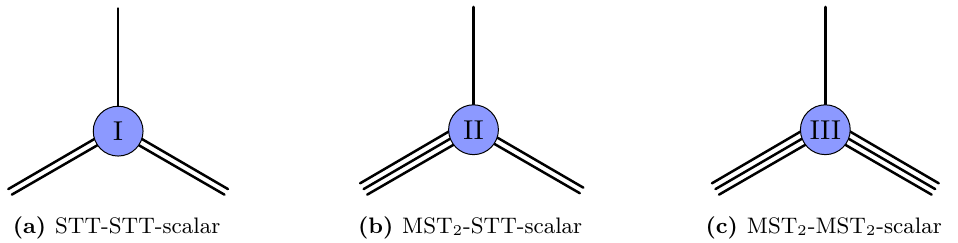
Figure 2. Vertices with an associated one-dimensional space of tensor structures. Single-lined legs are scalars; double or triple lines correspond respectively to STT and MST type III vertex in figure 2c, the space is two-dimensional and reduces to one dimension only in d = 4 .